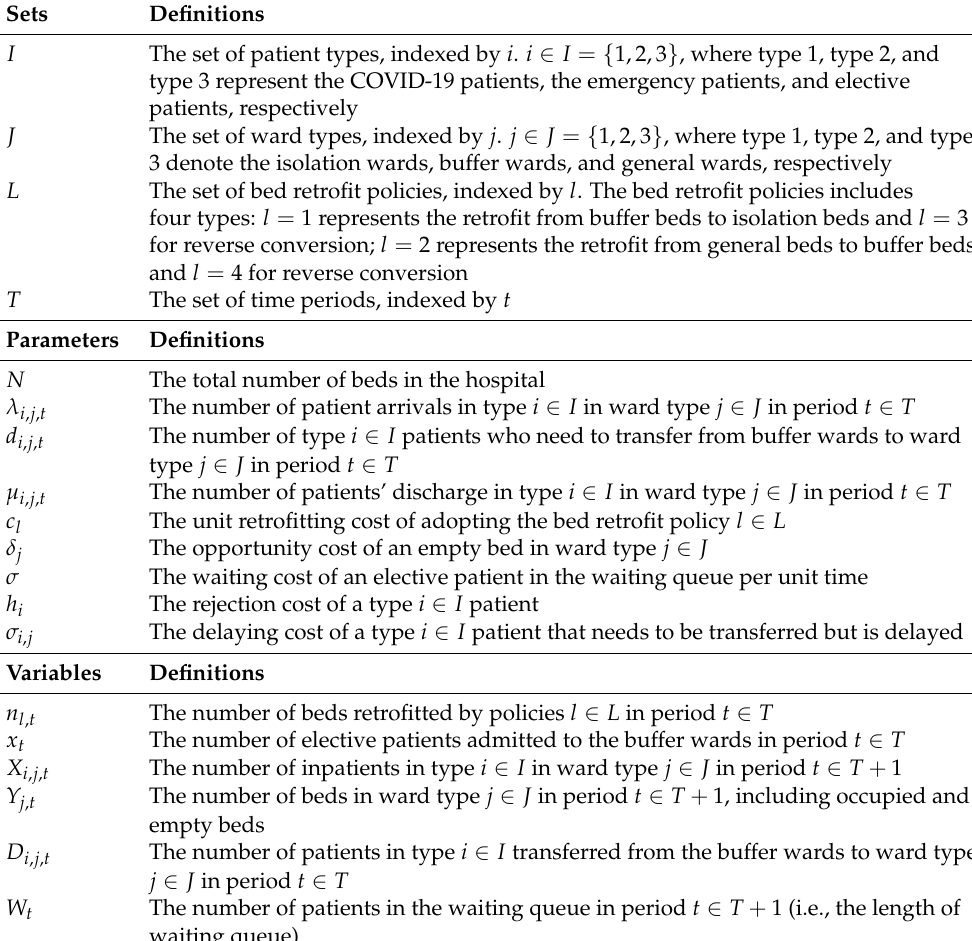
Table 1. Notations of the